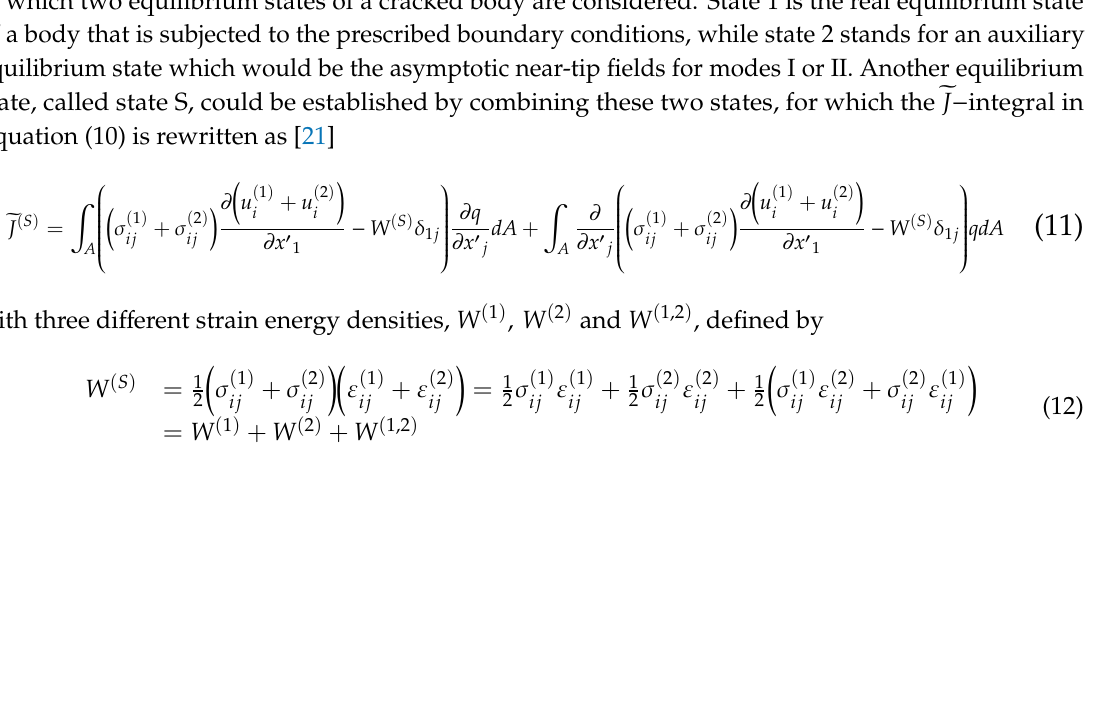
Γ and a donut-type domain of integration